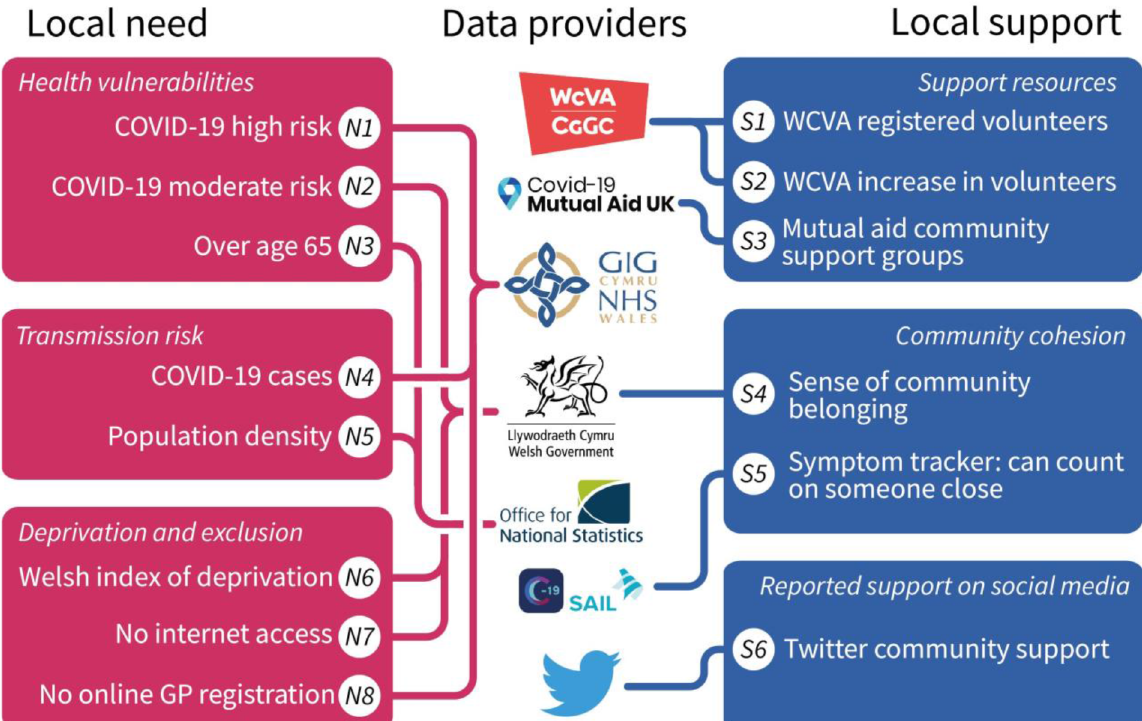
Figure 1: Diagram representing the mapping between Data Providers , and corresponding Variables for local need ( N ), and local support ( S ). Each box represents the Dataset each variable belongs to